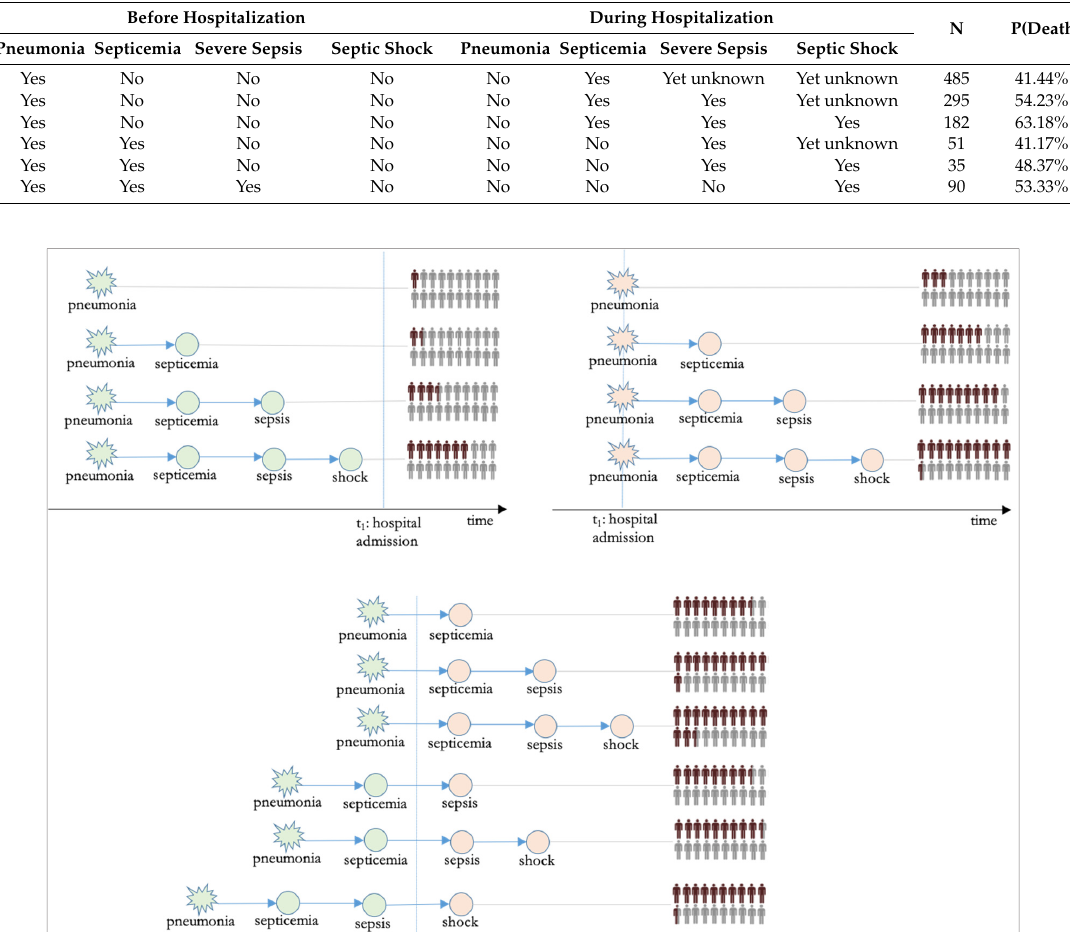
Table 6. Binary logistic regression to study the effect of bloodstream infection scenarios on hospital mortality.